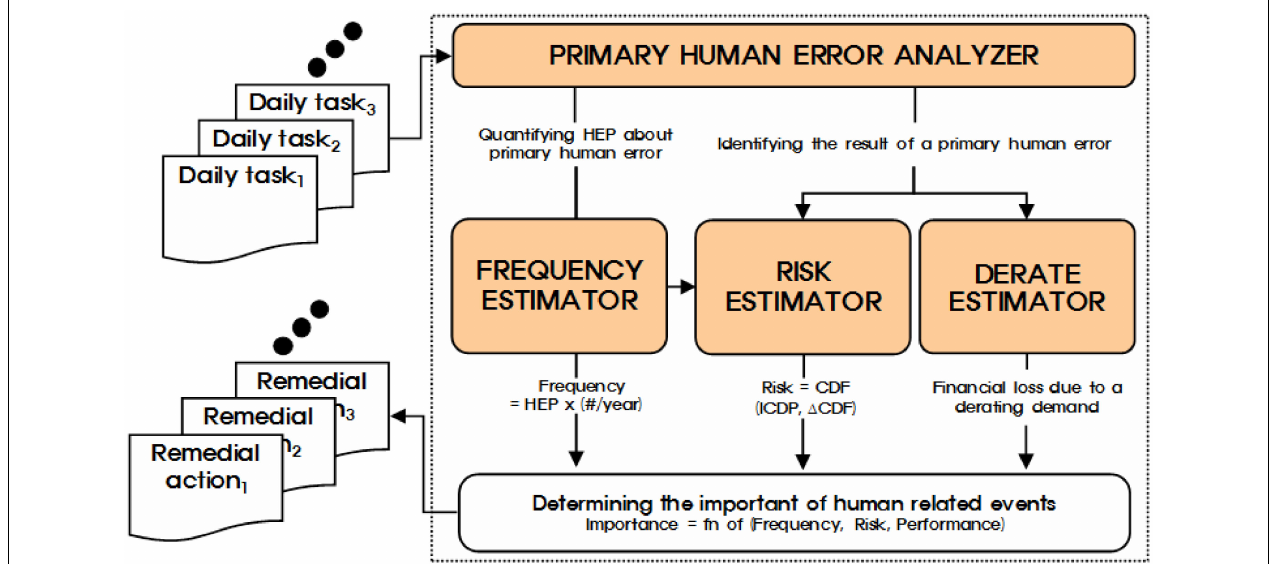
FIGURE 4 | Framework for evaluating the effects of maintenance-related human errors